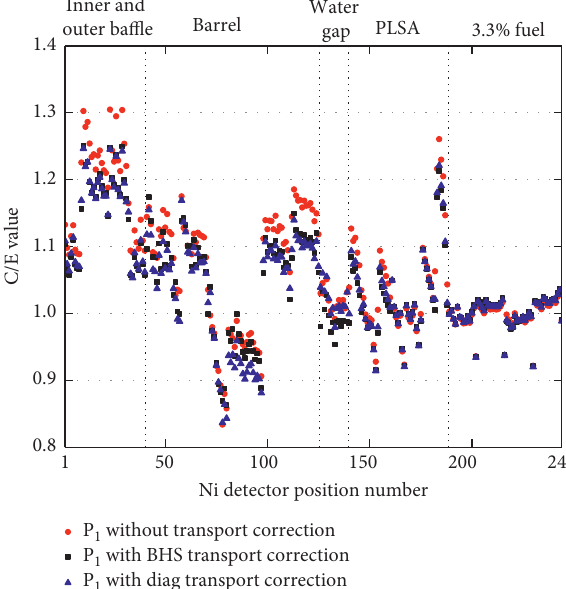
Figure 15: Comparison of Legendre expansion order of the 115 In(n,n’) 115m In detector.